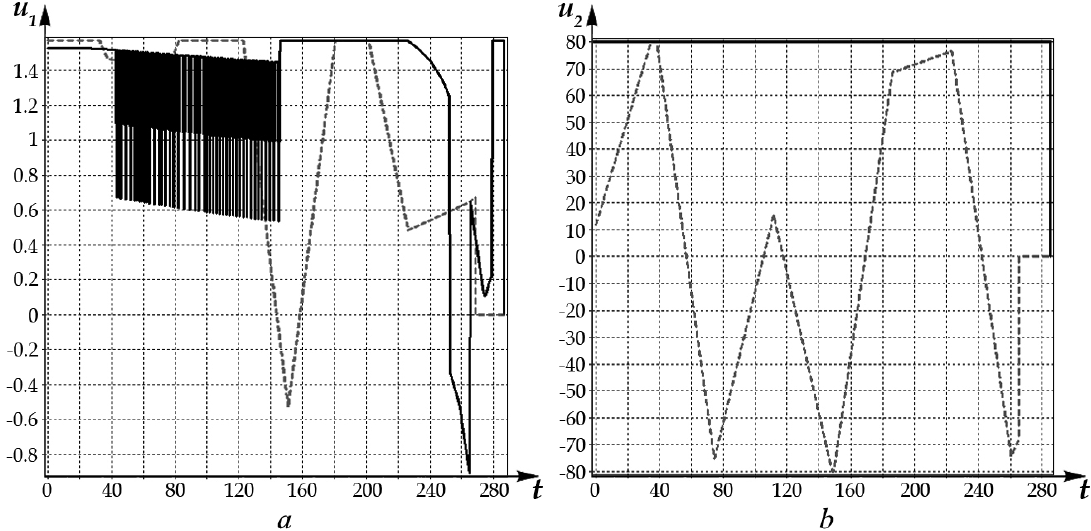
Figure 5. The graphs of control values over time: ( a ) control u 1 ( t ) ; ( b ) control u 2 ( t ) . Found solution—black solid line; reference solution—grey dashed